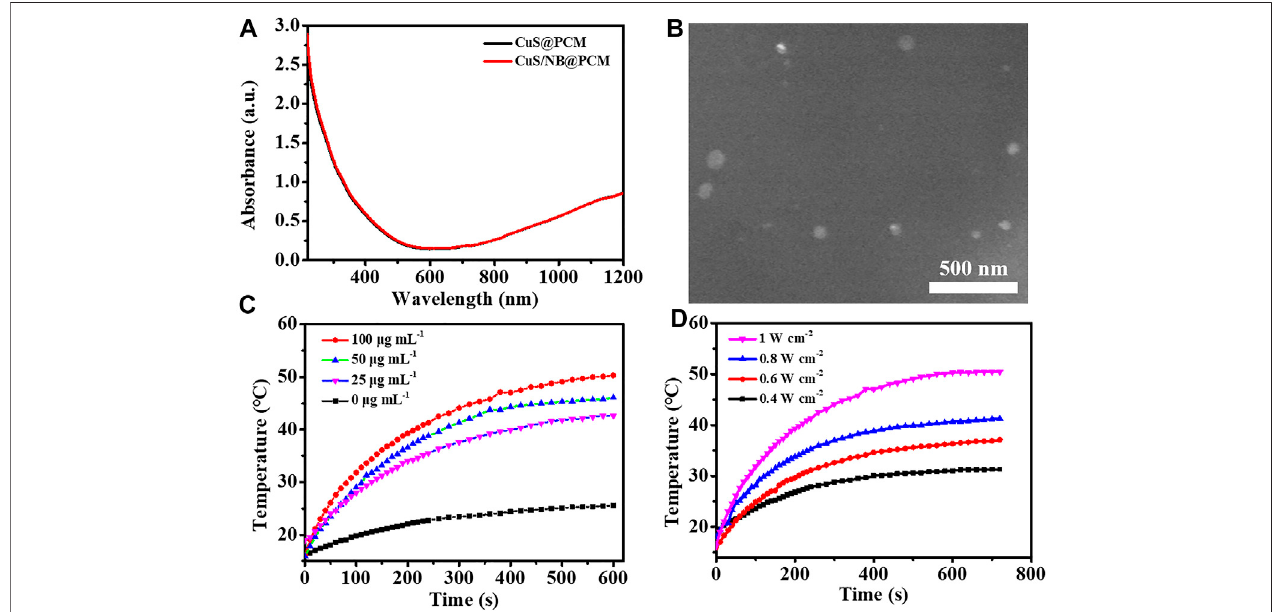
FIGURE 1 | (A) Absorption spectra of CuS@PCM NPs and NB/CuS@PCM NPs. (B) TEM image of NB/CuS@PCM NPs. (C) Elevated temperature pro fi le of different concentrations of NB/CuS@PCM NPs under 1,064-nm laser (1 W cm − 2 ) exposure. (D) The elevated temperature pro fi le of NB/CuS@PCM NPs (100 μ g ml − 1 ) under different densities of 1,064-nm laser